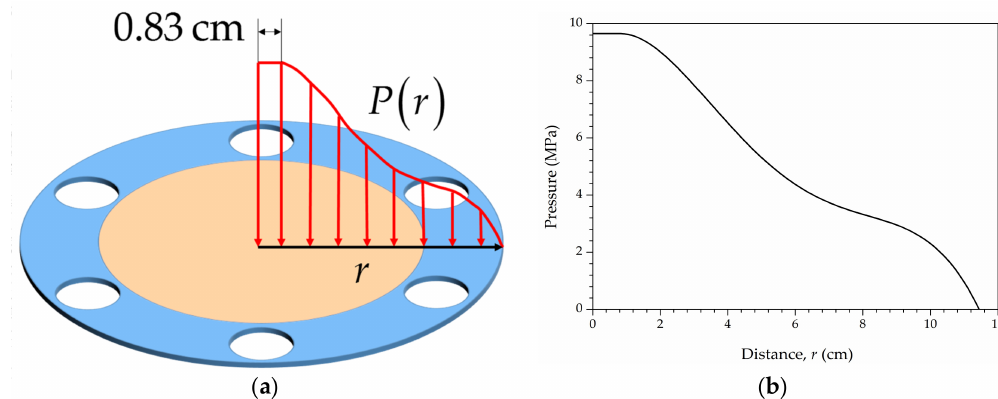
Figure 6. ( a ) Illustration of non-uniform pressure distribution over the top ply and ( b ) pressure